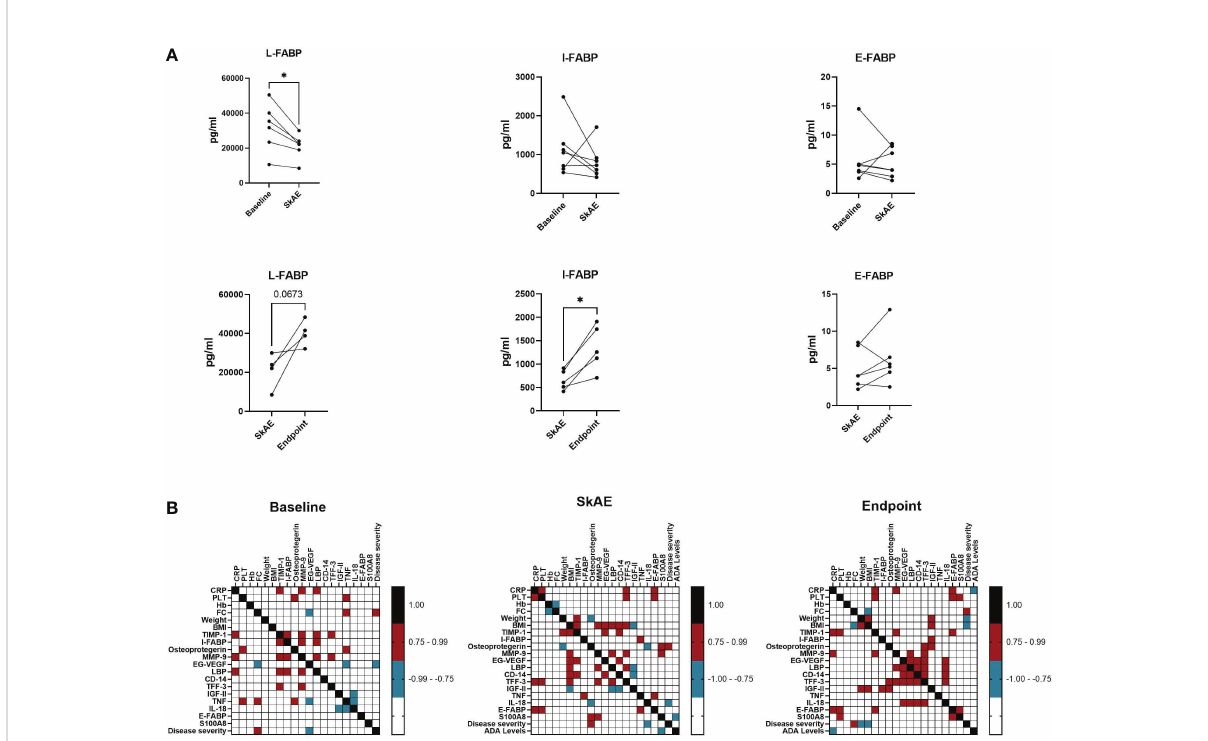
FIGURE 4 The analysis of I-FABP, L-FABP, and E-FABP in serum of patients with SkAE. (A) Comparison of L-FABP, I-FABP, and E-FABP levels in patients (n=7) at baseline, during the manifestation of SkAE and at the endpoint. For all panels: ( ∗ p < 0.05; paired t-test). (B) Correlation heatmap showing the Spearman ’ s correlation coef fi cient of pairwise comparison between clinical parameters and biomarkers at baseline, during SkAE incidence, and at the study endpoint (burgundy, positive correlation; turquoise, negative correlation). The heatmap was constructed in GraphPad Prism, version